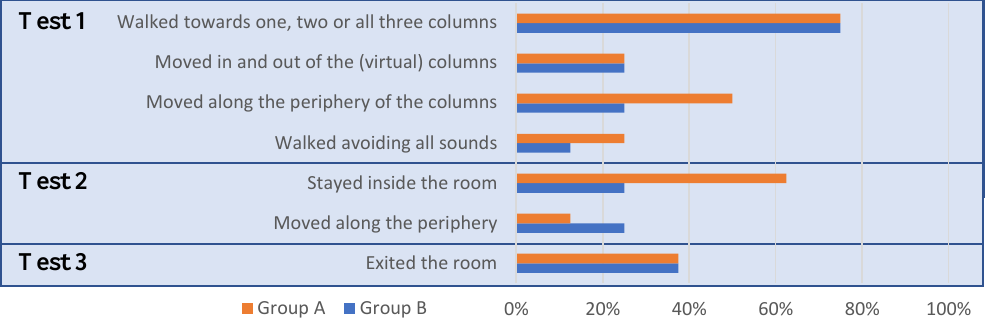
Figure 9. Common features of the scenarios described and drawn by the subjects. Figure 10. Subject A1′s drawing of the starting point and route followed in Test 1.